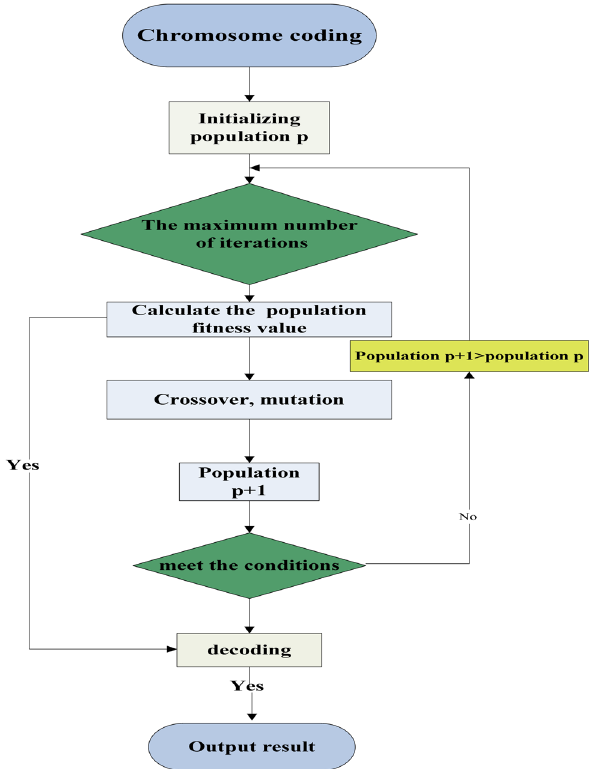
Figure 2: Genetic algorithm step